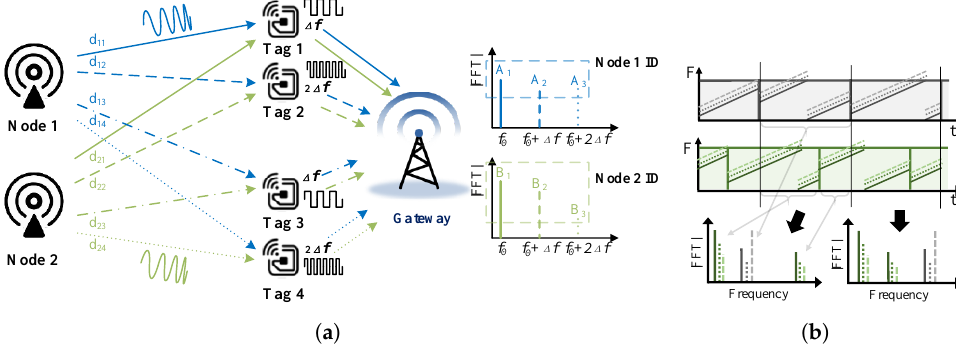
Figure 4. Signature creation with backscatter tags. ( a ) Position signature created by backscatter tags. ( b ) Collide packets with position